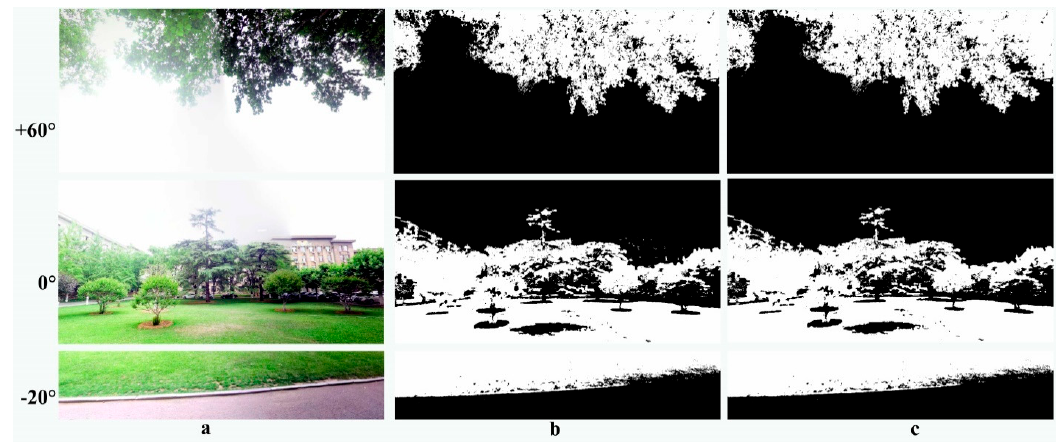
Figure 6. Green vegetation extracting results using a Support Vector Machine (SVM). ( a ) BSV images, ( b ) SVM processing results and ( c ) refinement results.